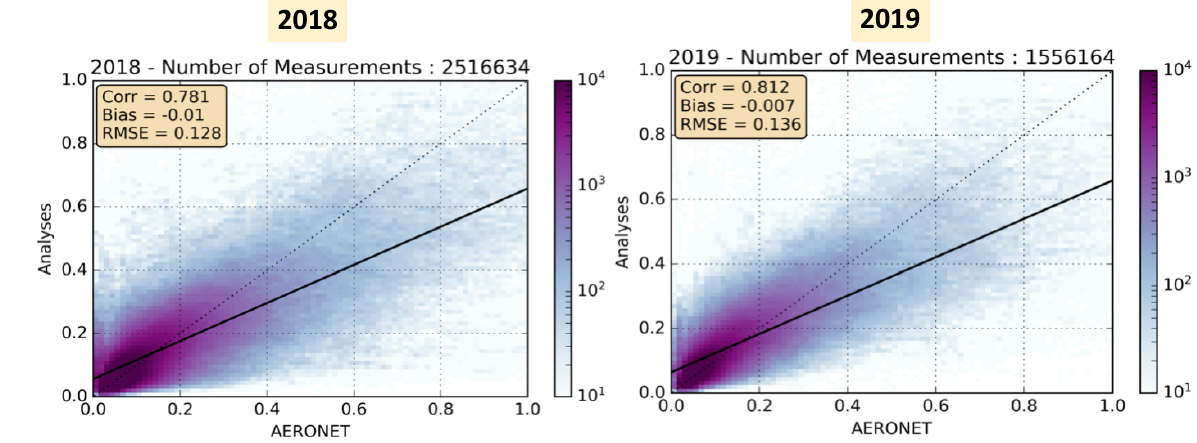
Figure 3. Scatter plots of AERONET AOD versus assimilated MODIS AOD for the two years of study: 2018 and 2019. The colours represent the number of counts for each comparison. Both comparisons correspond to the whole period of comparison: From 1 January until 31 December 2018 for the left panel, and from 1 January until 31 December 2019 for the right panel. The thick black line in each panel is the regression line for each